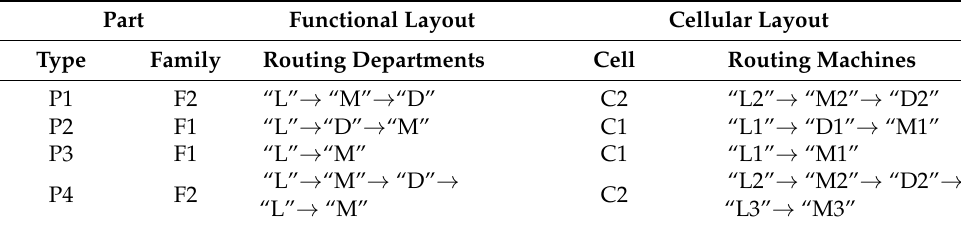
Table 4. Part routing used for the FMS case